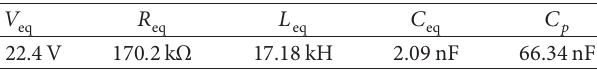
Table 4: Equivalent model parameters of the harvesting structure. 𝑉 eq